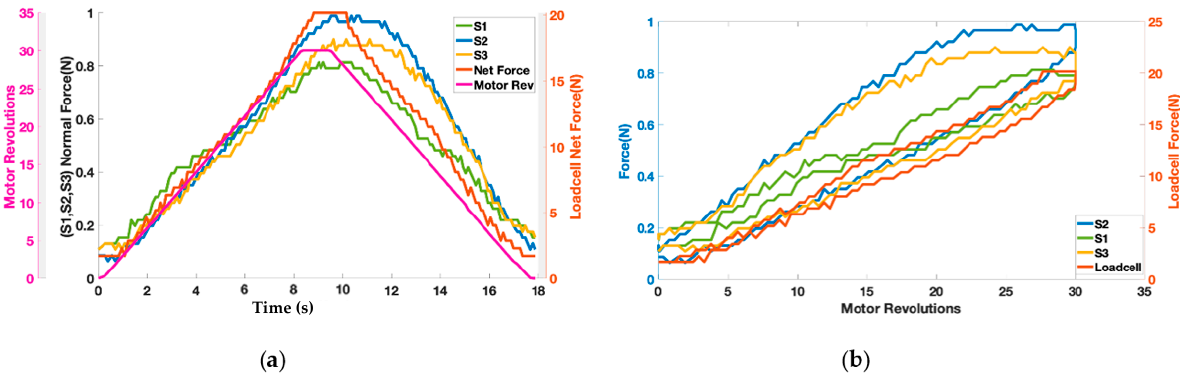
Figure 8. ( a ) Representation of contact reaction forces from single point force sensors and net resultant force along with ( b ) sensor hysteresis.